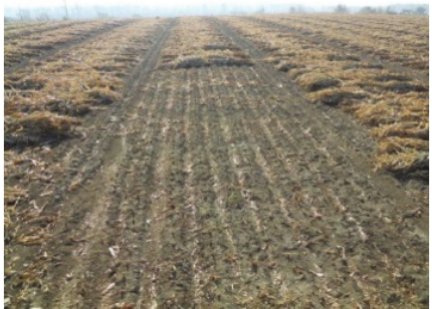
Figure 1: Truck-mounted C-band radiometer and its observing area.